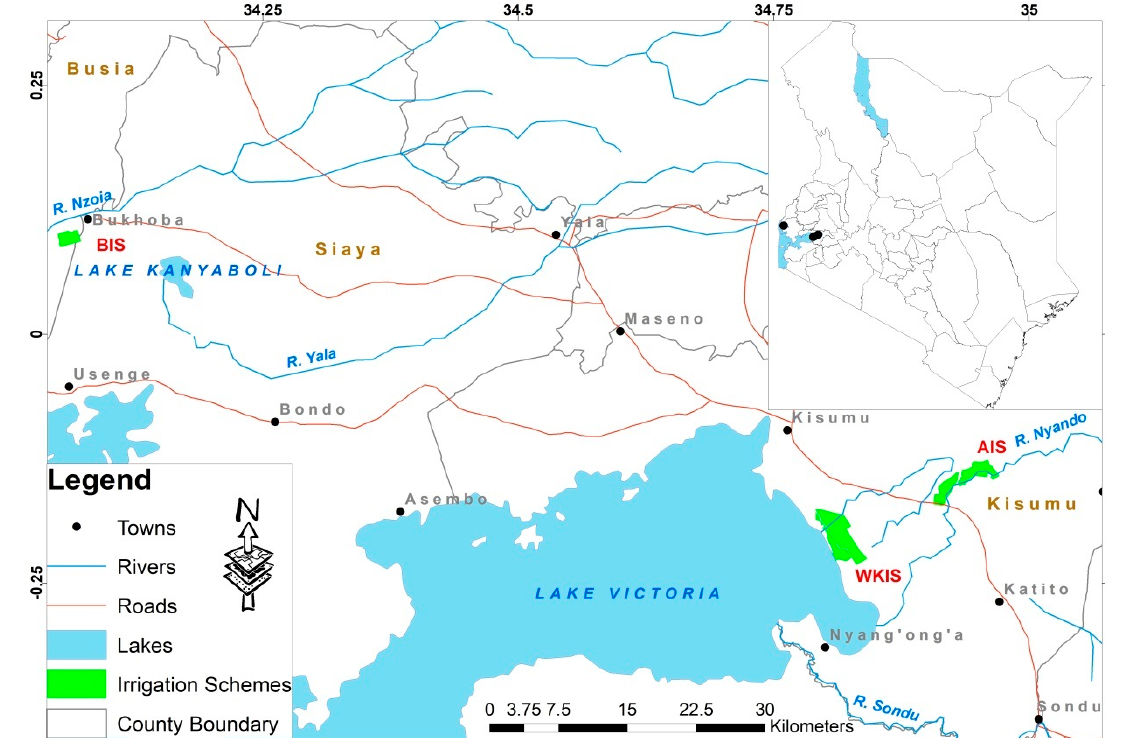
Figure 1. Study Area.